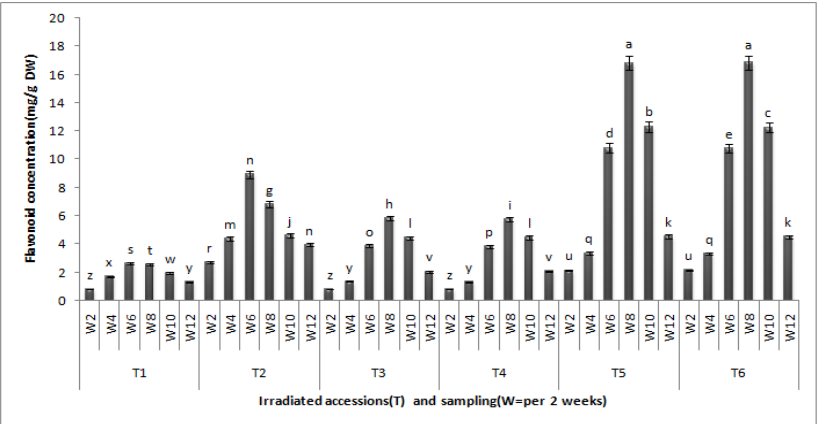
Figure 2. Effects of gamma irradiation on leaf total flavonoid, leaf biomass and flavonoid * leaf biomass in C.asiatica . n = 4 (T1 = CA03 (Control); T2 = CA23 (Control); T3 = CA03 irradiated to 30 Gy; T4 = CA03 irradiated to 40 Gy; T5 = CA23 irradiated to 20 Gy; T6 = CA23 irradiated to 30 Gy; W2 = 2 weeks after planting; W4 = 4 weeks after planting; W6 = 6 weeks after planting; W8 = 8 weeks after planting; W10 = 10 weeks after planting; W12 = 12 weeks after